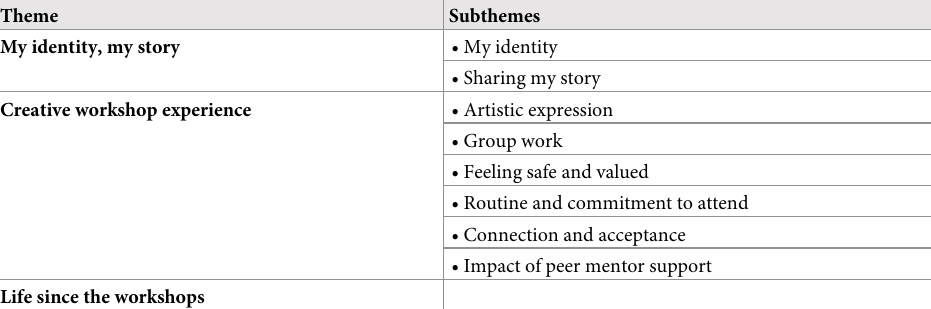
Table 2. Summary of themes and